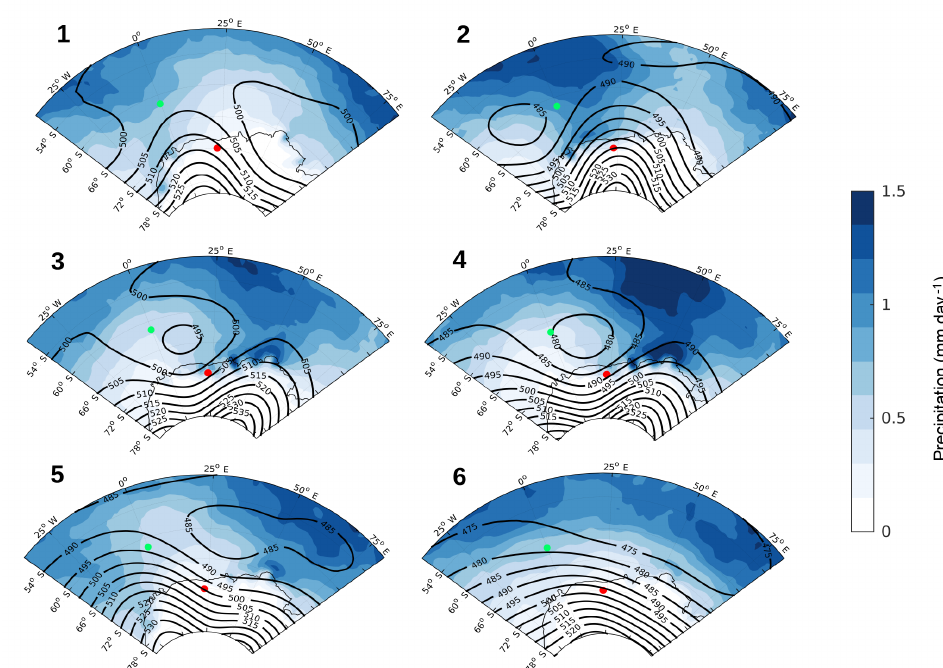
Figure 3. Weather atlas illustrating the circulation climatology over Dronning Maud Land. Thick lines denote the 500hPa geopotential fields, while blue colours show average precipitation amounts linked to this circulation. The red dot indicates the location of the Princess Elisabeth station, while the green dot denotes the location over the ocean used for calculating the pressure gradient (Sect. 3.3). The Antarctic circumpolar trough is identified. The depiction sequence of the circulation types describes the typical west–east movement of the